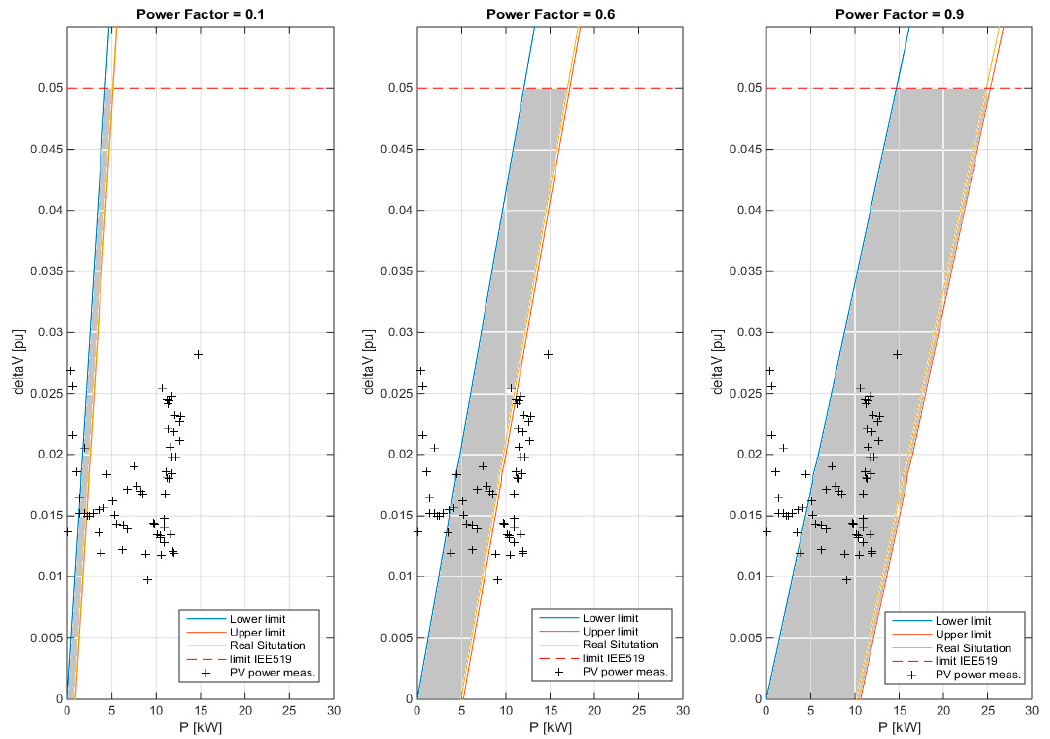
Figure 7. Variation of the hosting capacity region for different power factors.